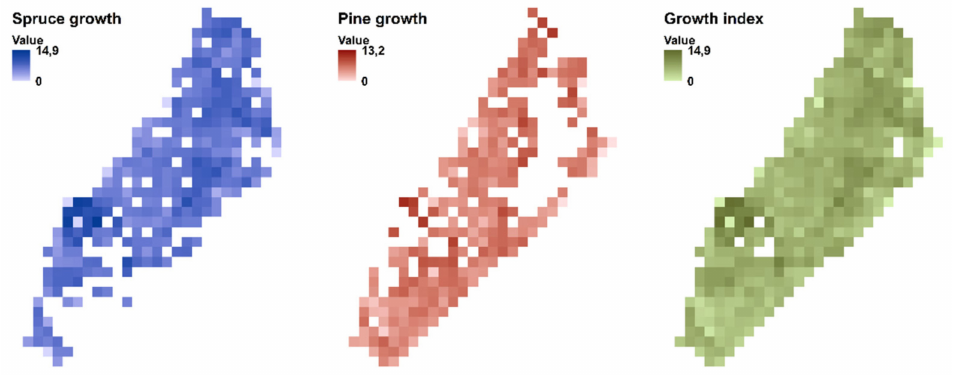
Figure 1. Maps of mean annual volume growth (m 3 /ha/year) in study stand no. 49, estimated by the past growth of Norway spruce ( left ), Scots pine ( middle ) and combination with the maximum value of Norway spruce or Scots pine ( right ). The estimated growth (average of 9 neighboring grid cells) varied from 3 to 14 m 3 /ha/year in the case